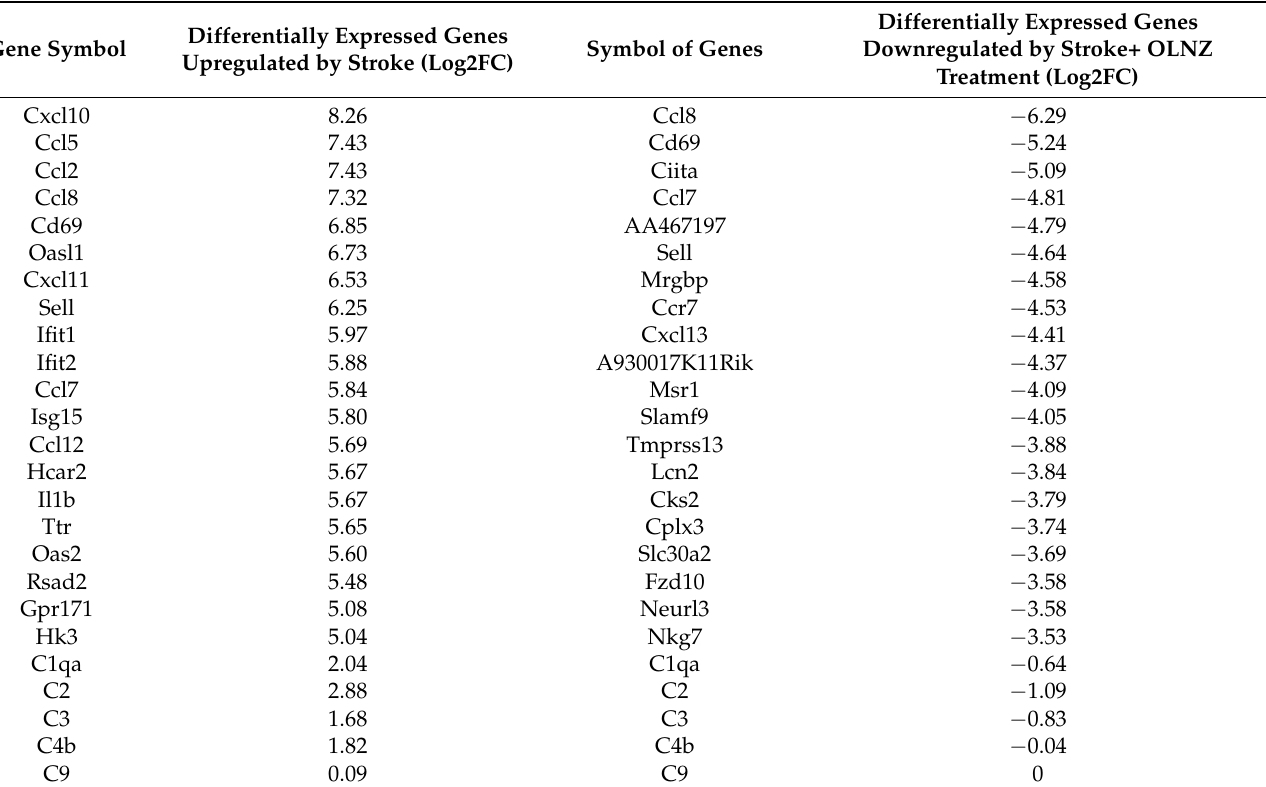
Table 2. List of the few most upregulated protein-coding genes in the transient-ischemia (TI)-induced stroke model in gerbils, and the few most downregulated protein-coding genes in the TI-induced stroke + olanzapine treatment group.